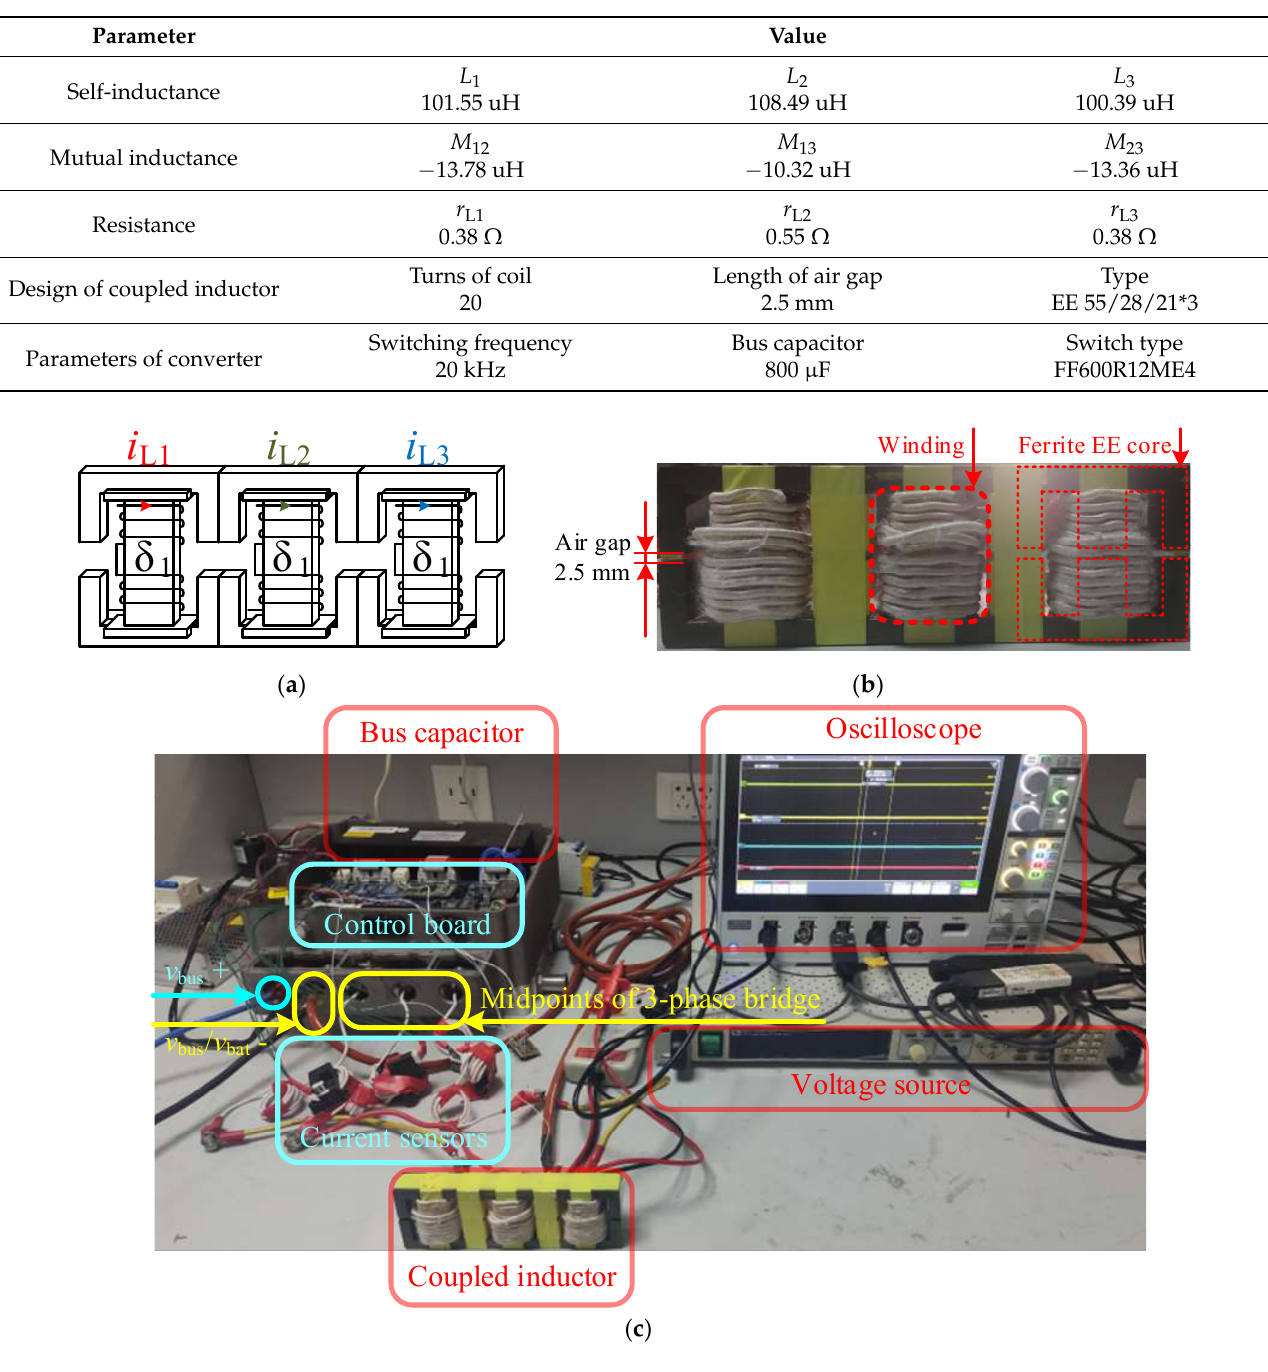
Table 3. Parameters of a 3-phase coupled buck–boost converter.